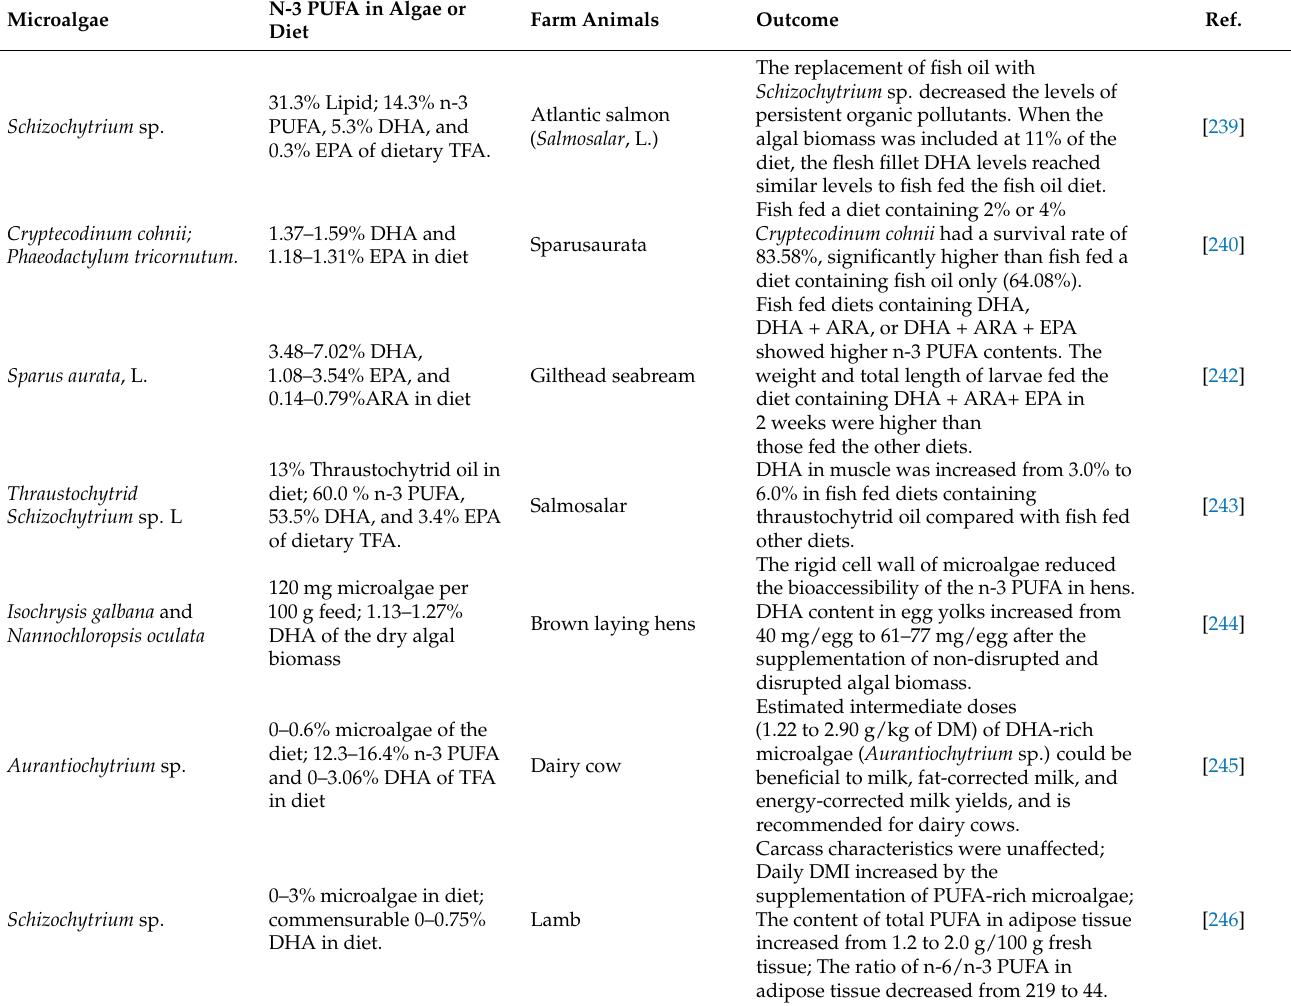
Table 3. Feeding farmed animals with n-3 PUFA-rich biomass or oil (Modified from table in